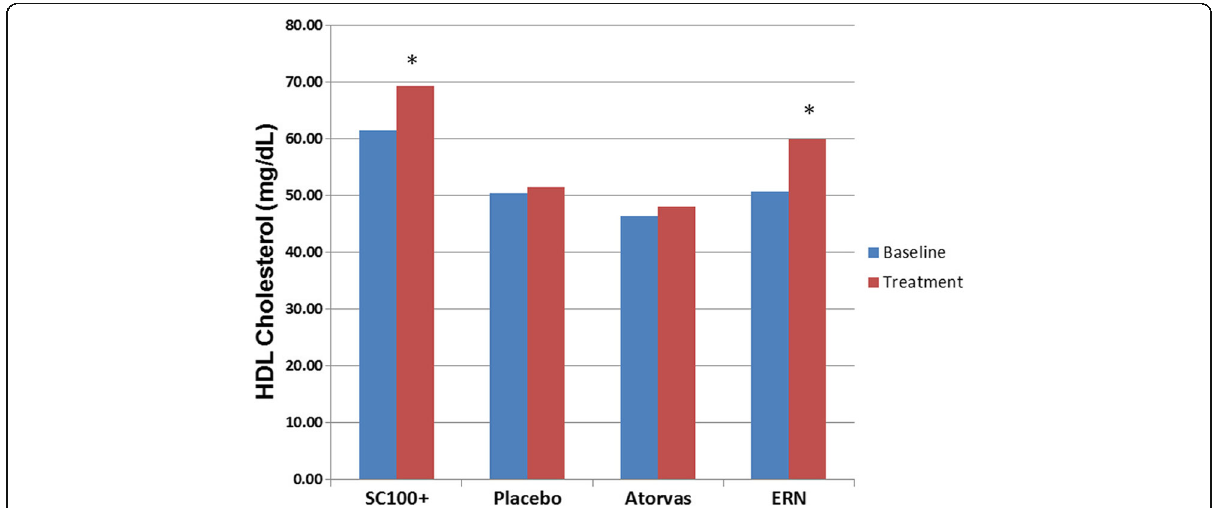
Fig. 3 SC100+ raises mean HDL Cholesterol after 15 weeks. HDL Cholesterol was measured at baseline and after 15 weeks of taking SC100+. SC100+ raised mean HDL Cholesterol 12.8% ( p <0.005 in paired t tests). While SC100+ is not a treatment for low HDL Cholesterol, Fig. 3 also compares SC100+ to the effects of treatment with the drugs Atorvastatin (Atorvas at 10 mg/day for 6 weeks, N =64) in a placebo-controlled ( N =22) clinical trial [70], and Extended Release Niacin (ERN at 1500 mg/day for 6 weeks, N =27), which is taken from a placebo-ERN crossover clinical trial [71]. All stared results are significant with p